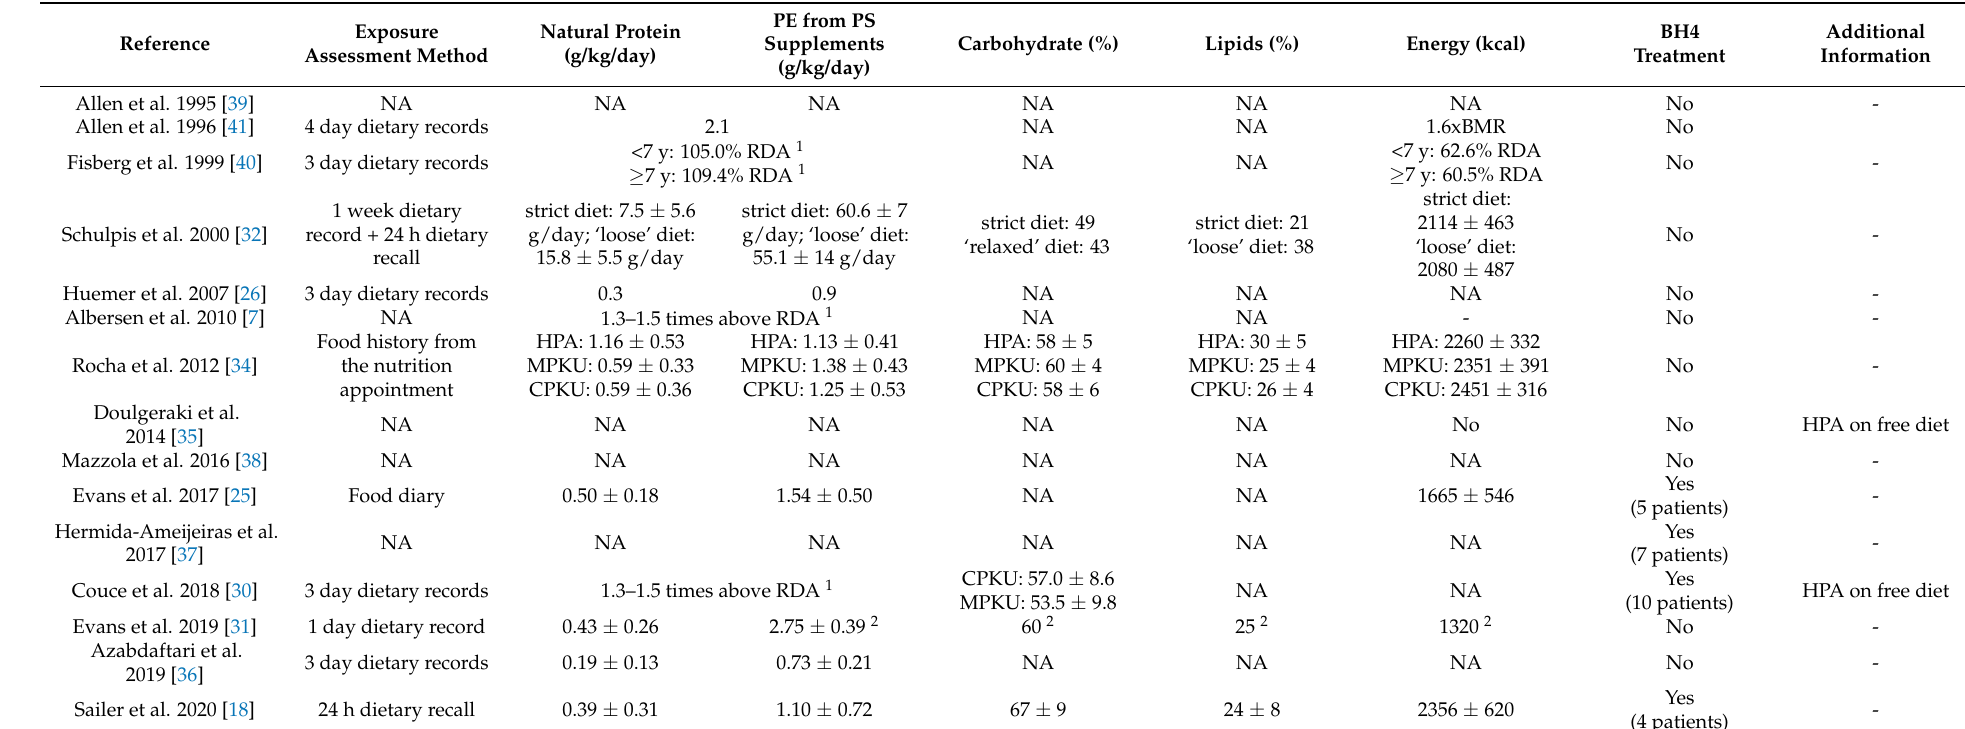
Table 2. Exposure assessment method and nutritional intake of participants in the included